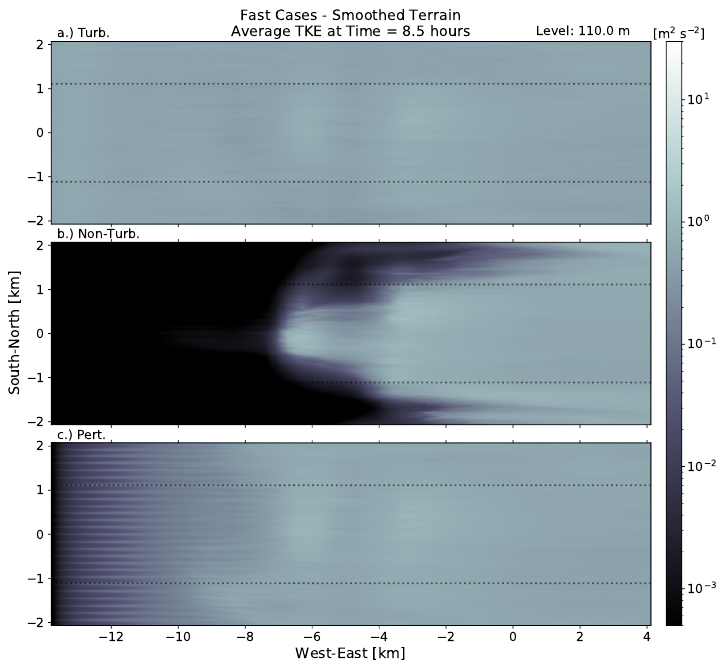
Figure 17. Same as in Figure 4 but for time-averaged TKE for simulations over smoothed terrain in the Fast cases for the ( a ) Turbulent, ( b ) non-turbulent, and ( c ) cell perturbation simulations.